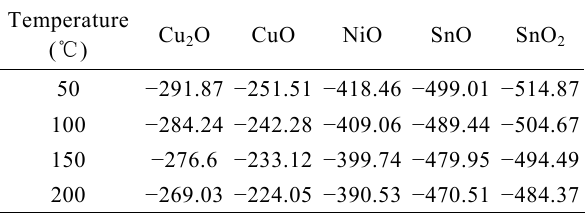
Fig. 15 Wear mechanism map for Cu–15Ni–8Sn–0.8Nb alloy against 300M steel under a grease-lubricated condition. Table 1 ∆ G of oxides formed at different